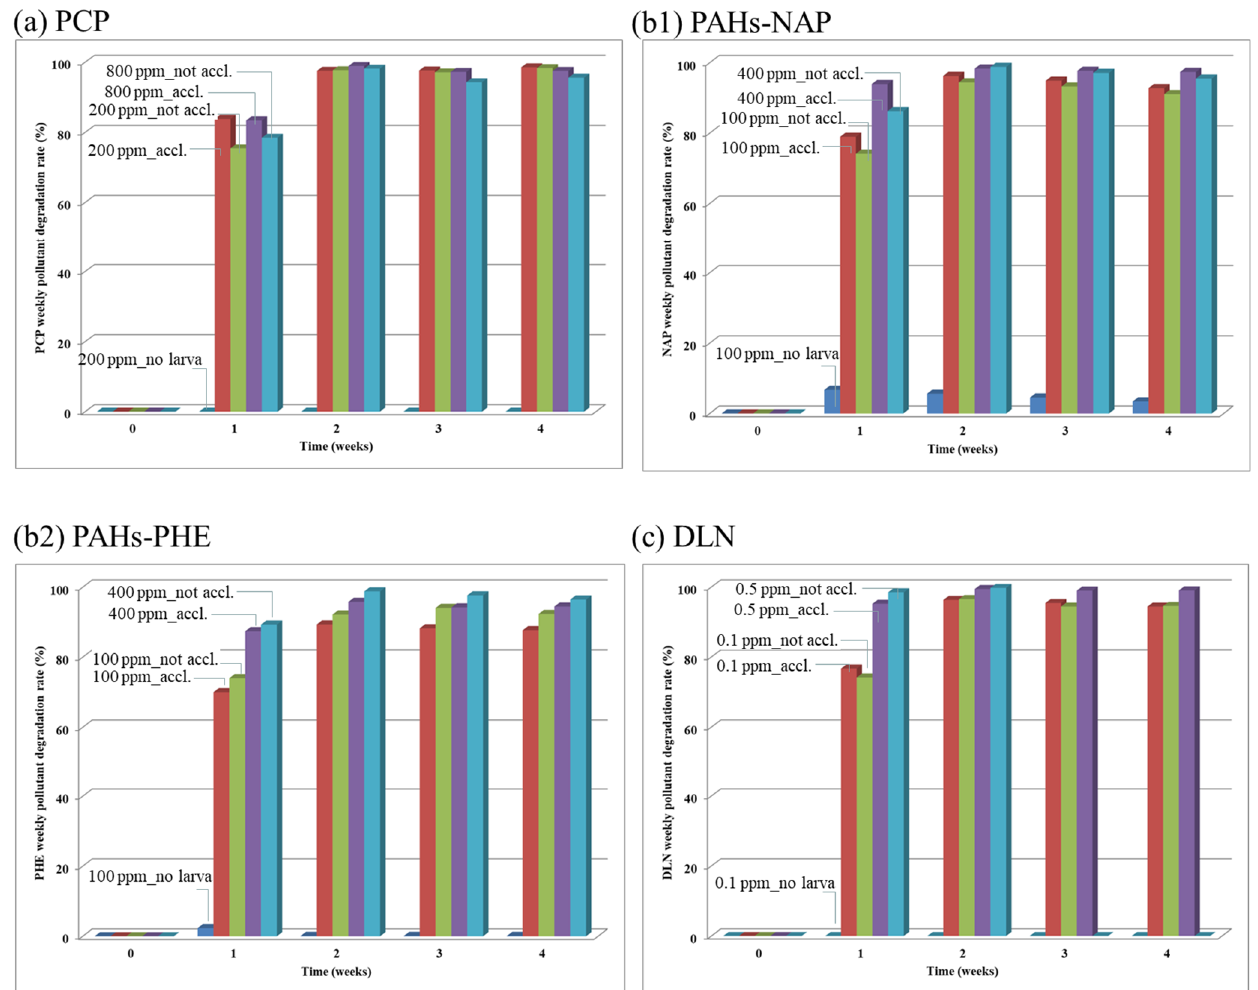
Figure 7. Weekly degradation rates of the tested PCP, PAHs-NAP and PHE and DLN, as labeled in ( a ), ( b1 ) and ( b2 ) and ( c ), respectively.